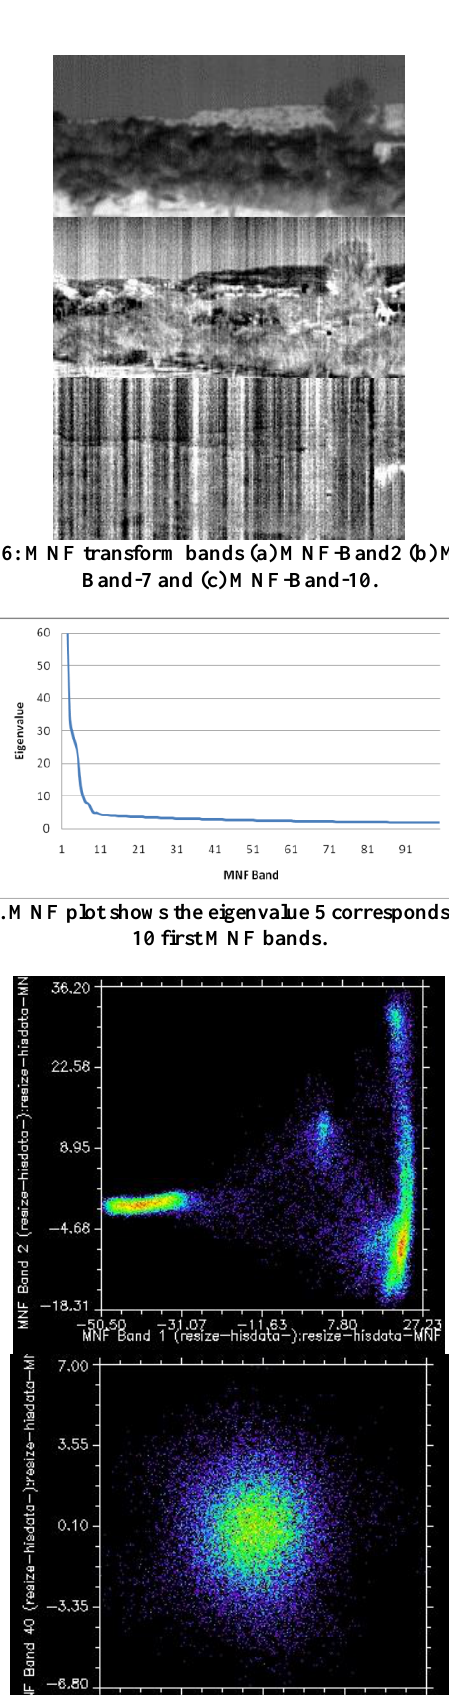
Fig.7. 2-D ScatterPlot of MNF EignValue (a) MNF bands 1&2 (b) MNF bands 39&40